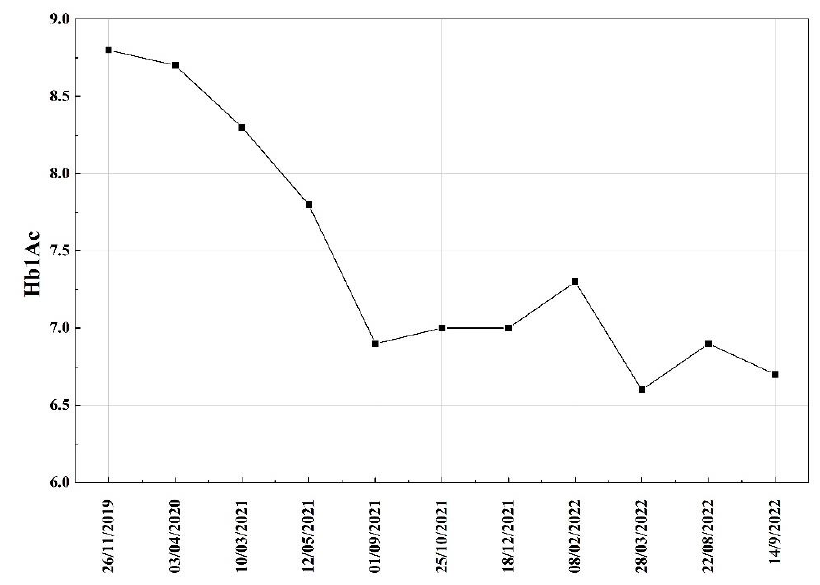
Figure 2. Evolution of HbA1c levels from November 2019 to the present day.